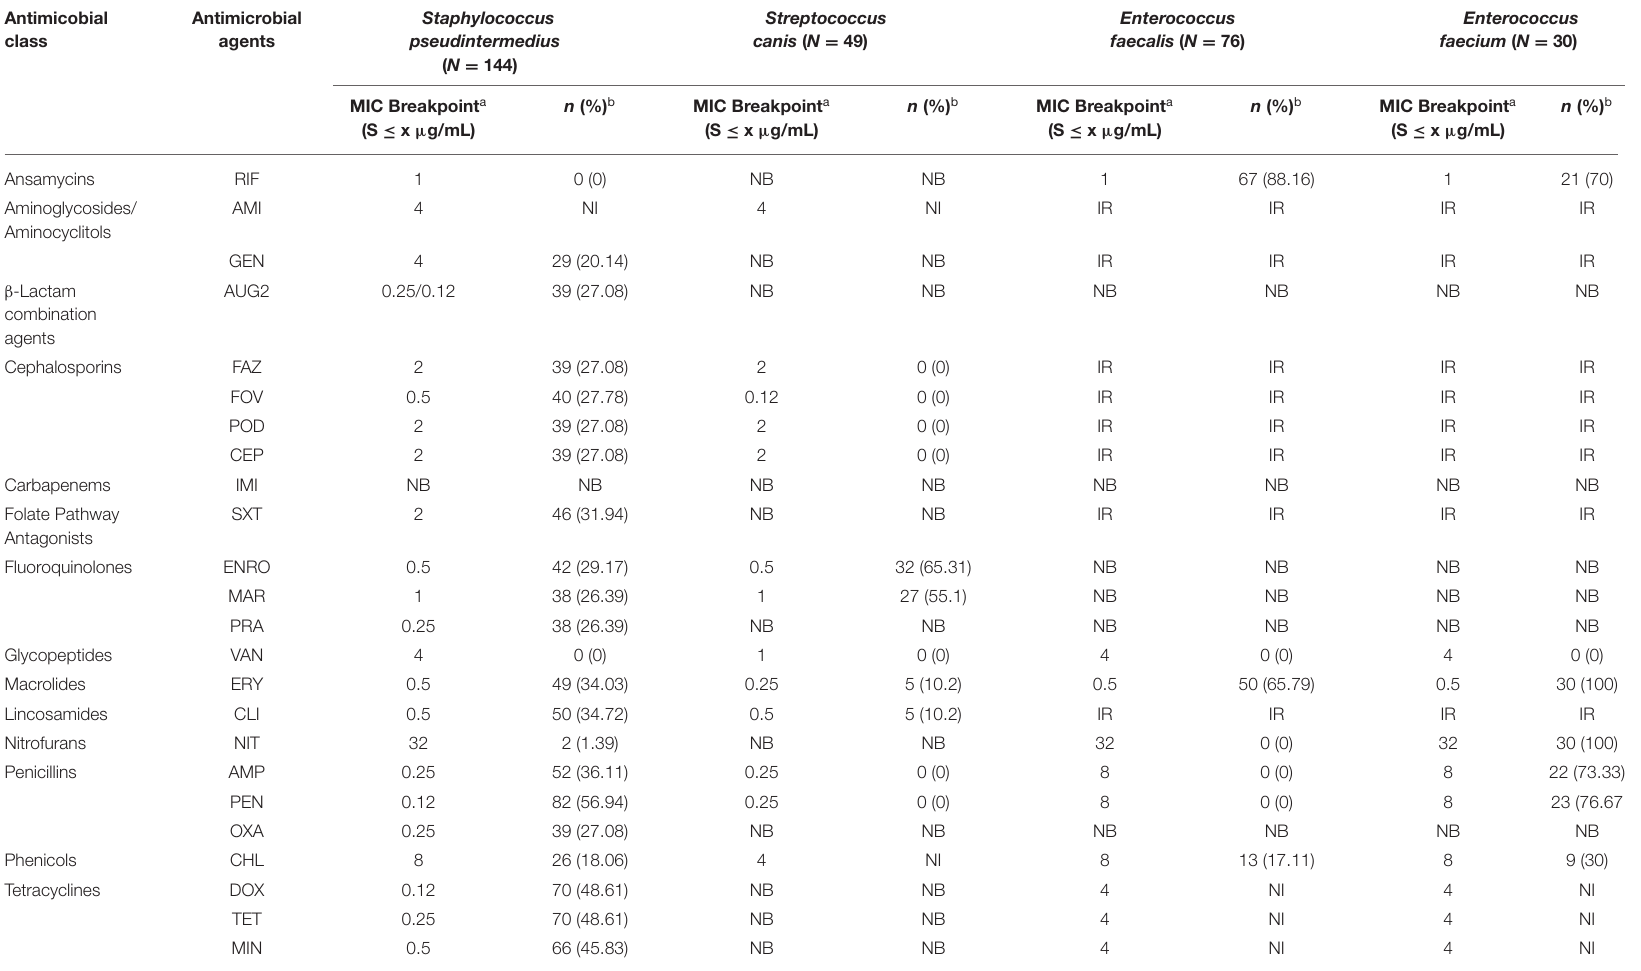
TABLE 1 | The proportion of antimicrobial resistance in Gram-positive bacteria isolated from urine samples submitted to the Veterinary Diagnostic Laboratory, University of Illinois, College of Veterinary Medicine, 2019–2020. Antimicobial